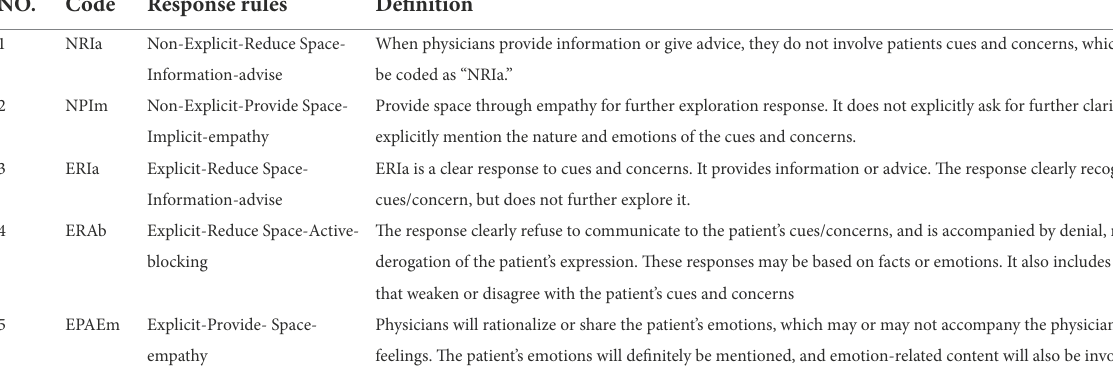
TABLE 1 Communication strategy description based on